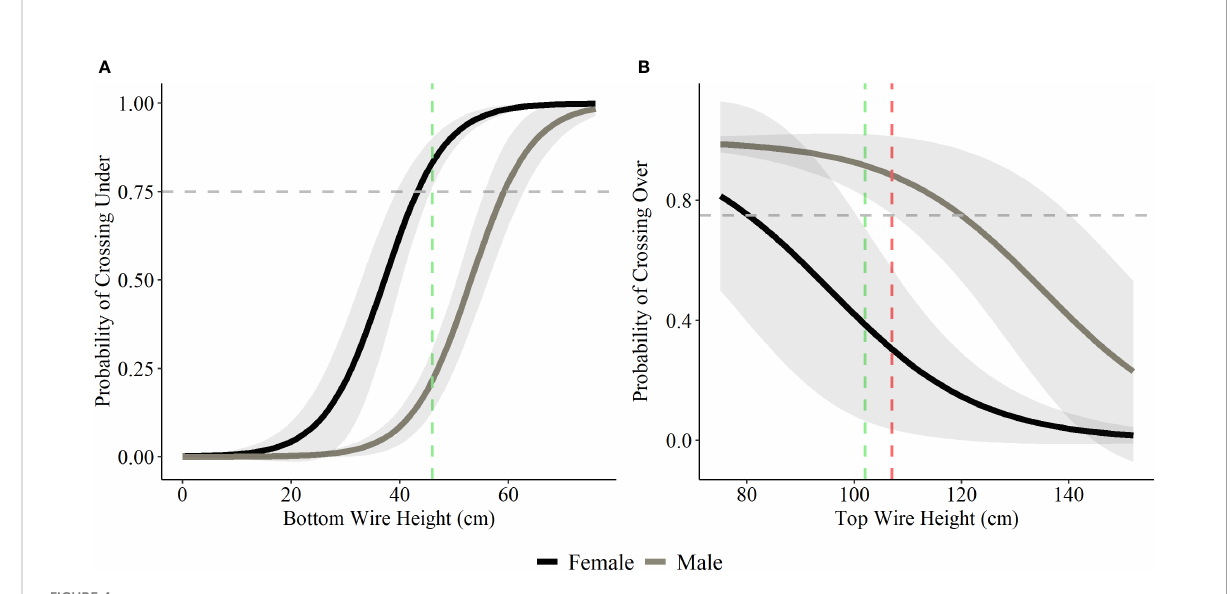
FIGURE 4 Probability of mule deer choosing to cross under (A) and over (B) fences based on a range of bottom and top wire heights. We display the current recommended bottom wire height of 46 cm (18 inches; green) and top wire heights of 102 cm (40 inches; green) and 107 (42 inches; red) as the coloured vertical dashed lines in each graph based on the recommendations for wildlife-friendlier fences (Paige, 2020). The horizontal grey dashed line represents the 75% probability of choosing to cross over or under the fence.